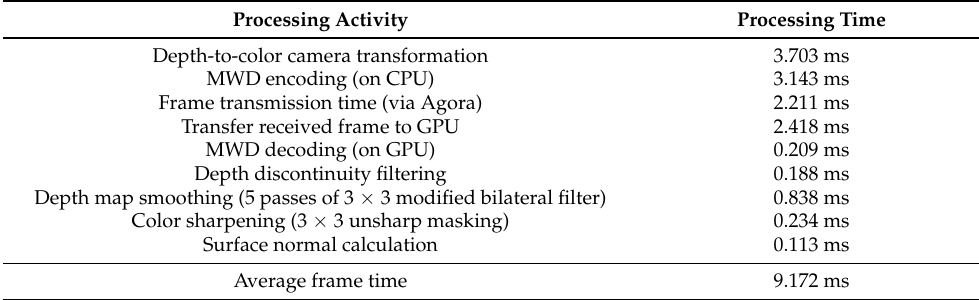
Table 4. Performance timings during a live HoloKinect video conferencing session. The general settings mirror those used in Section 3, with the Agora video stream having a total resolution of 2560 × 720. The MWD encoding used n stairs = 6 and other settings are as described in the first paragraph of Section 3.2. Additional postprocessing settings were enabled as detailed in the table, with black level thresholding being directly integrated into the MWD decoding function. Timings were each taken as a rolling average of 1000 samples. These measurements were made on a Windows 11 desktop PC equipped with an Intel Core i9-12900K (Intel Corp., Santa Clara, CA, USA) and an NVIDIA GeForce RTX 3090 Ti (NVIDIA Corp., Santa Clara, CA, USA).